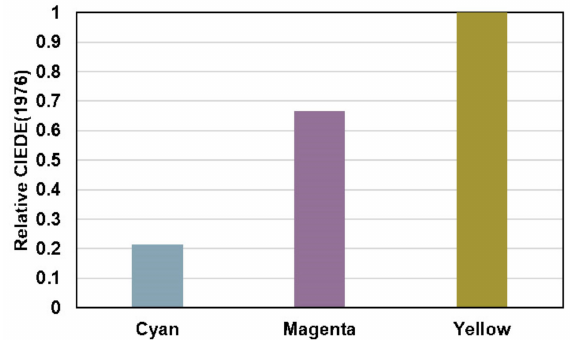
Figure 7. Relative CIE ∆ E(1976) of single colored spots of C, M and Y VIS-trigger-able photochromic 12 µ m prints (5 wt-% colorant system content) in contrast to the background (STYRENE plastic sheets). An optimum colorization of the VIS-trigger-able photochromic prints can be achieved by illuminating the single spots for 3–5 s (Figure